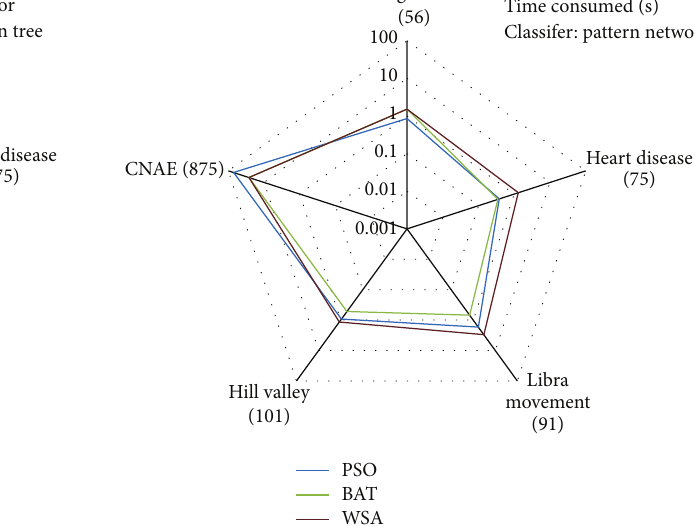
Figure 5: Results in classification error for Decision Tree are shown visually in radar chart.